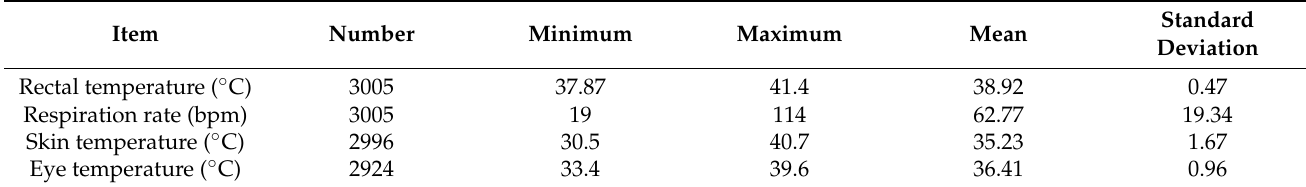
Table 2. Descriptive statistics for the animal-based indicators during this